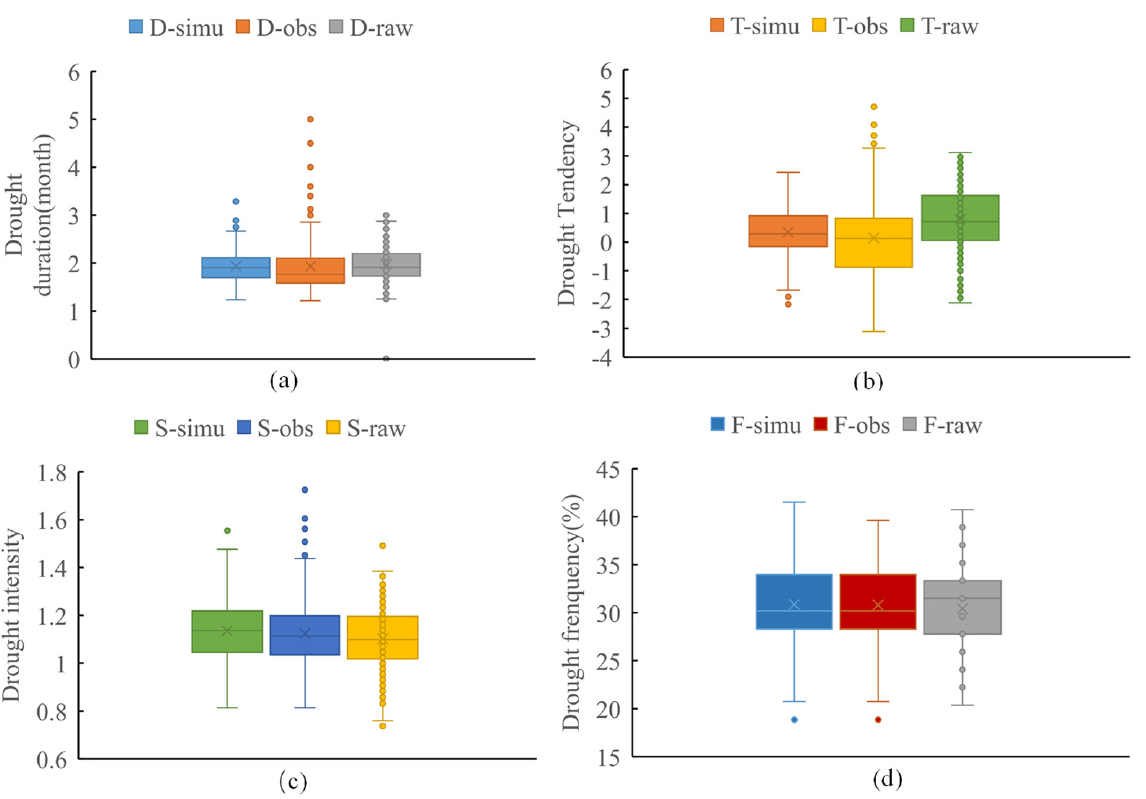
Figure 5. The drought characteristics of raw GCMs, corrected GCMs, and observed data; ( a ) Drought Duration, ( b ) Drought Tendency, ( c ) Drought intensity, ( d ) Drought frequency. The “D”, ”T”, ”S”, and ”F” is drought duration, drought intensity, drought trend, and drought frequency, respectively. The “sim” means the corrected GCMs; the “obs” means the observed data.